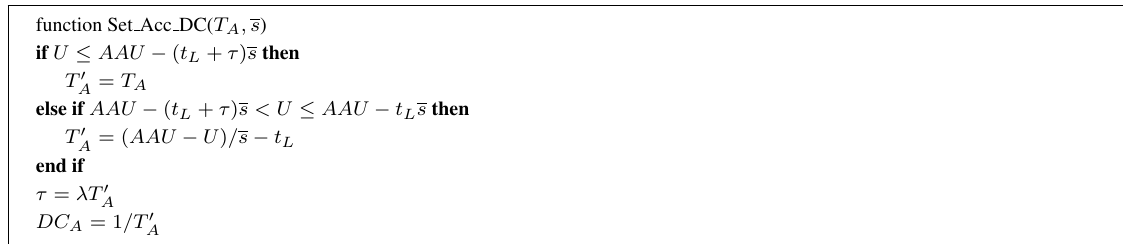
Figure 5. The Set Acc DC()